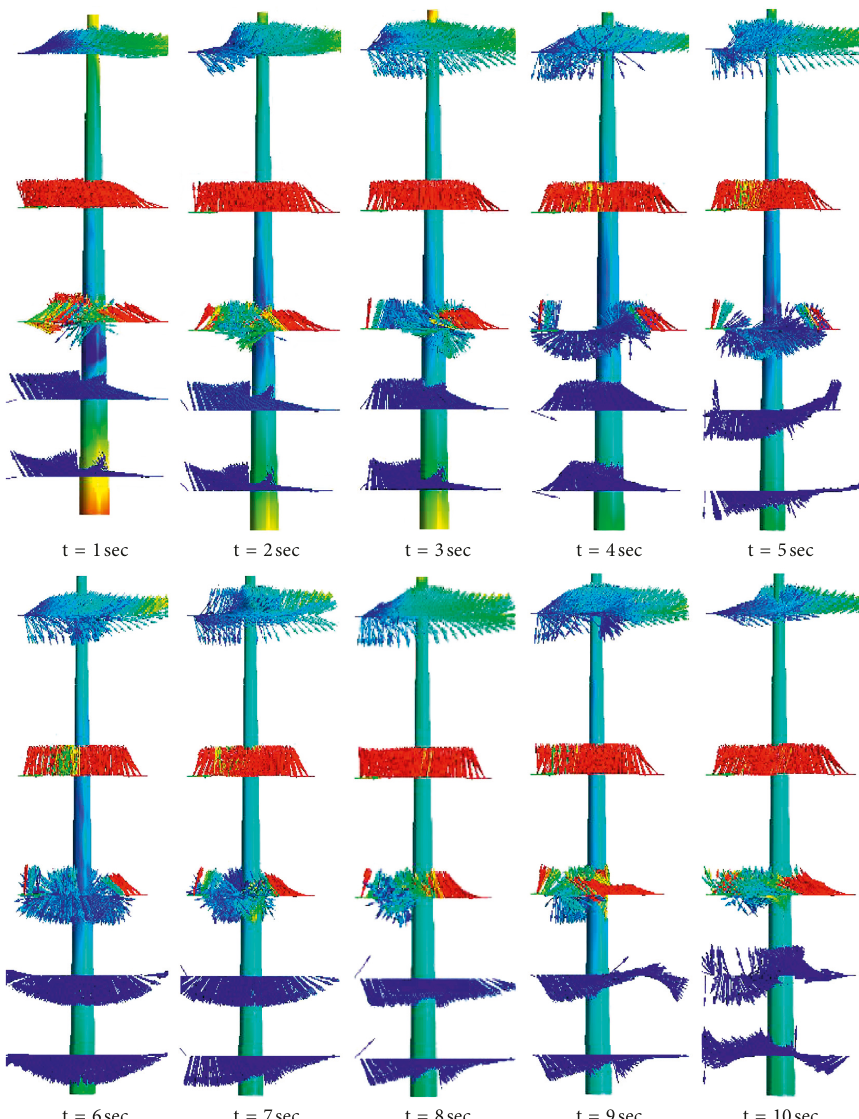
Figure 10: Velocity vectors of fluid domain around the wind